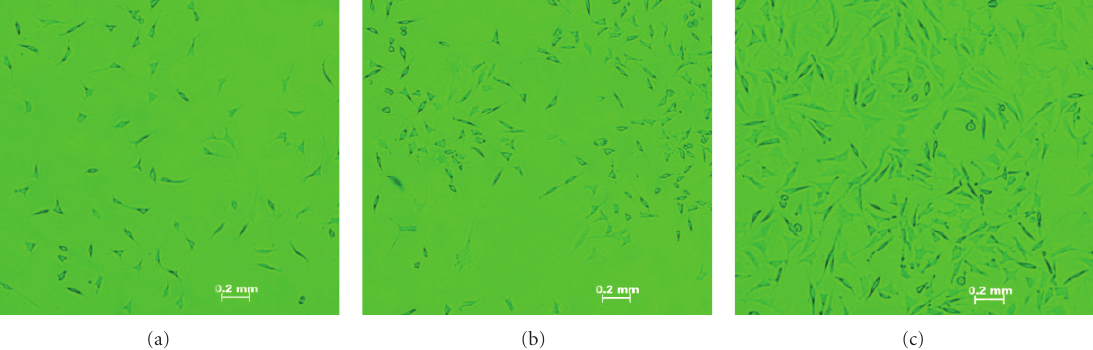
Figure 7: The morphological observation of the L929 fibroblasts incubated in RPMI-1640 at di ff erent culture time (40 × ): (a) 2 days; (b) 4 days; (c) 7 days.